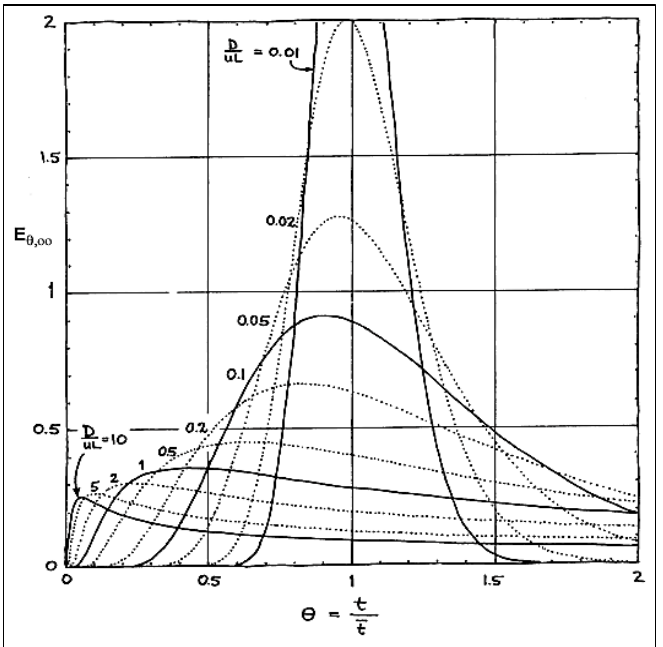
Figure 7: Dimensionless response for open-open boundary conditions as reported by Levenspiel.